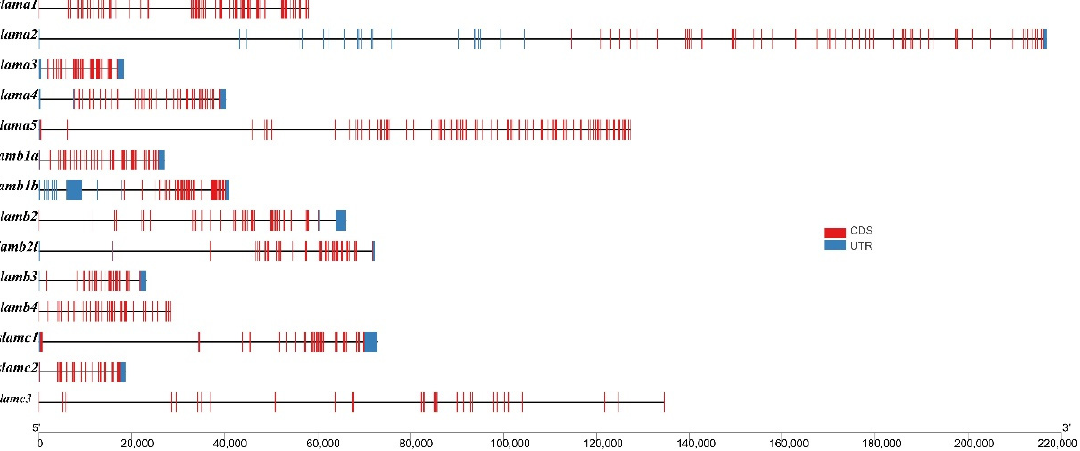
Figure 4. Gene structures of 14 laminin genes. The black solid line represents the intron region. The blue rectangle represents the UTR region, and the red rectangle represents the exon region.